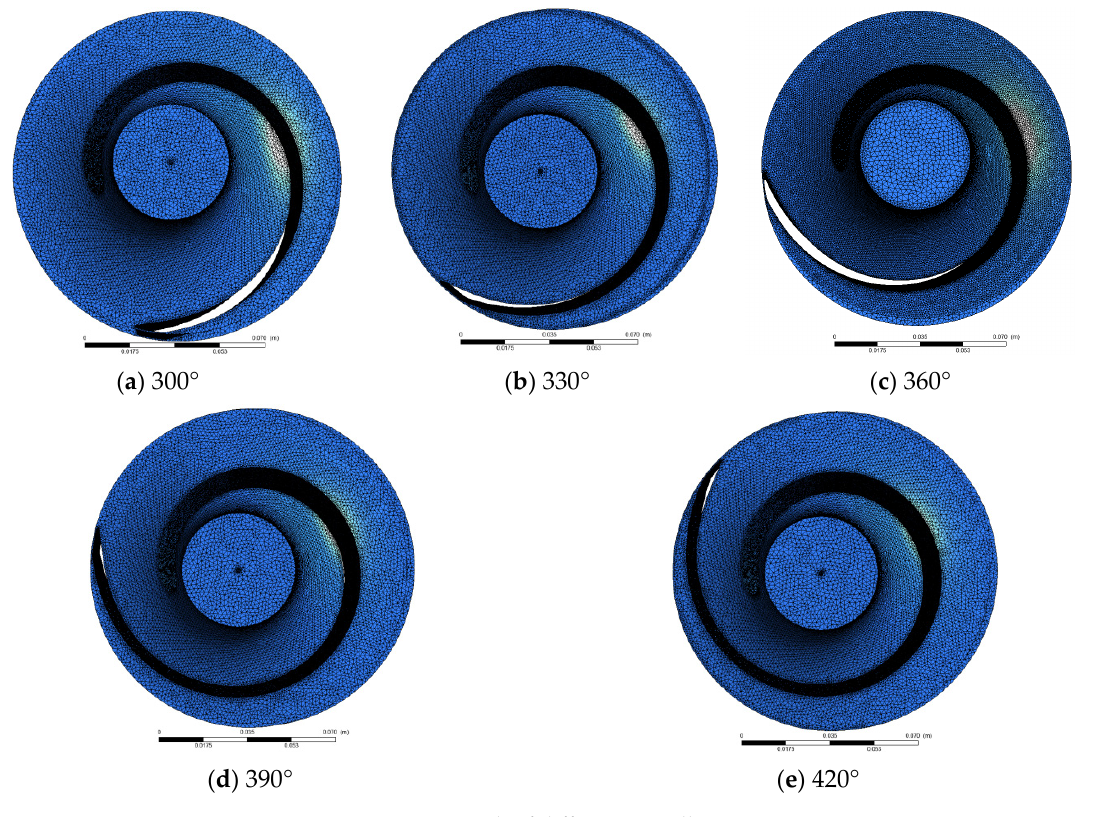
Figure 2. Mesh of different impellers.